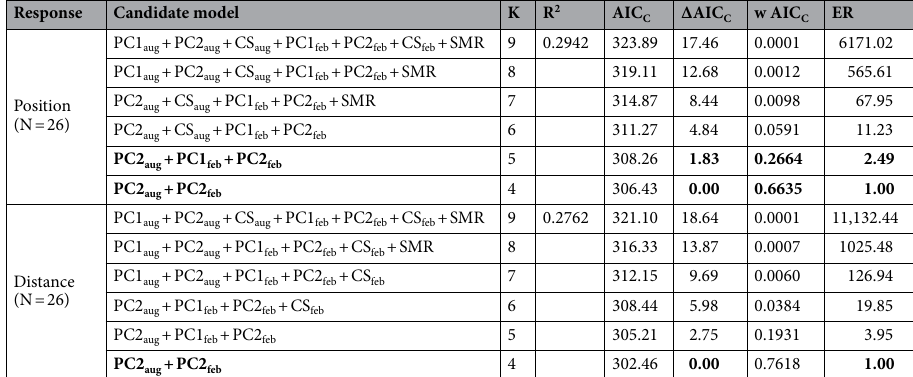
Table 3. Comparison of AIC C deltas and weights for general linear models testing the effects of metabolic rate (SMR; measured before release), initial body size (centroid size, CS aug ), final size (CS feb ), initial shape (PC1 aug , PC2 aug ), and final shape (PC1 feb , PC2 feb ) on secondary dispersal (maximum distance from the release point) and settlement positions of juvenile brown trout along the stream axis at the end of the experiment (day 158). Shown are the number of parameters (K), the resulting AIC C , the ΔAIC C , AIC C weight and the evidence ratios (ER). The best model and models roughly equivalent to the best (ΔAIC C ≈ 2 or lower) are highlighted in bold. *Six out of the 32 fish captured by day 158 had not been measured for SMR and therefore were excluded from these analyses.